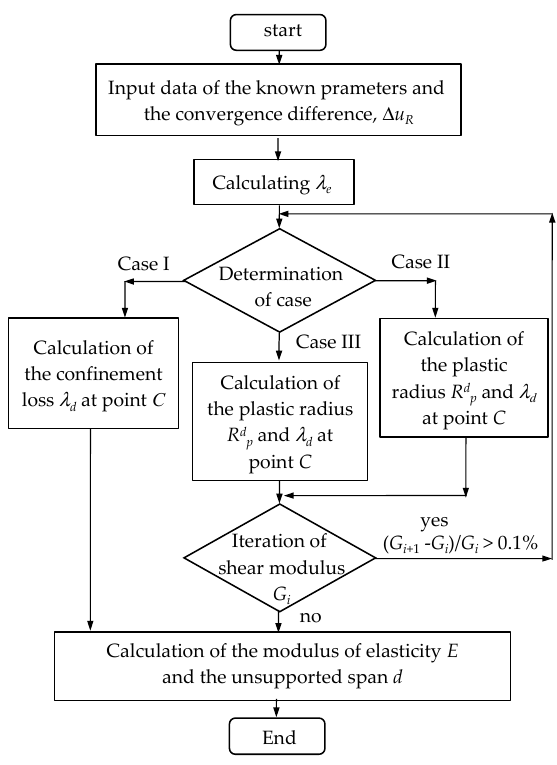
Figure 3. Computational flowchart of the ICM.